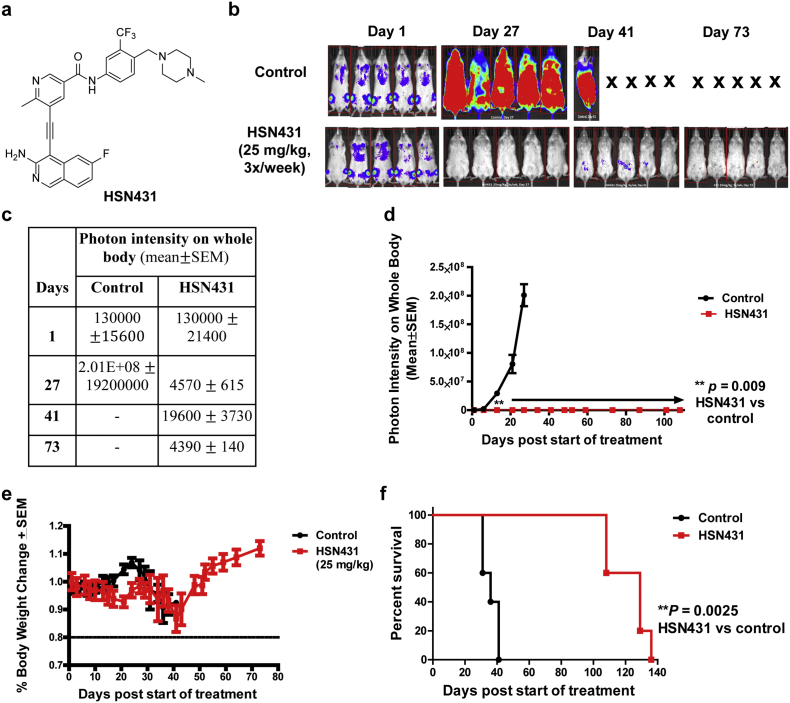
Evaluation of the in vivo efficacy of HSN431. (a) Structure HSN431. (b) The effect of HSN431 (25 mg/kg IP; 3×/week) treatment on mice (n = 5) implanted with FLT3-ITD harboring MV4–11 cells. (c) Table of photon intensity on whole body values for images shown in (b). (d) Quantification of leukemia burden in mice by measuring photon intensity (emanating from bioluminescent MV4–11 cells) on whole body of different treatment groups (control versus HSN431) over time. (e) Body weight measurements of control versus HSN431 treatment. (f) Survival traces for the mice treated with HSN431 and control until day 140. **P < .01.